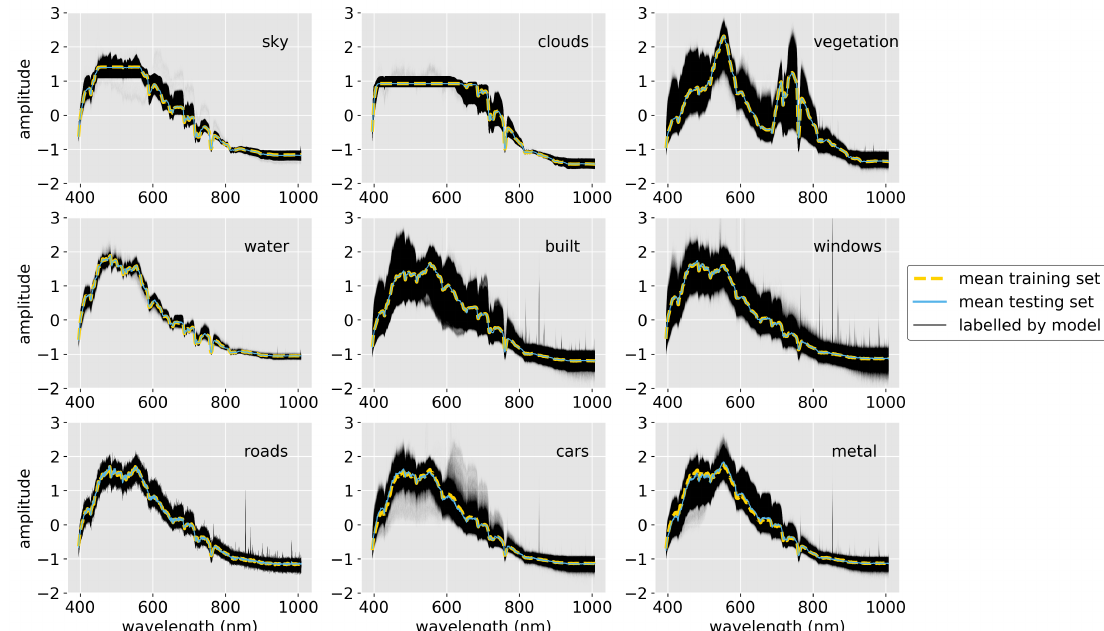
Figure 15. The spectra of each class of pixels in Scene 1-a as classified by Model 2, together with the mean spectra of the training and testing instances used in creating the model. Both Sky and Clouds pixels contain significant saturation for the sample from 450-650 nm while Vegetation pixels show peaks at ∼ 550 and ∼ 725 nm consistent with enhanced chlorophyll reflectivity at those wavelengths. The remaining classes show very subtle differences in spectral